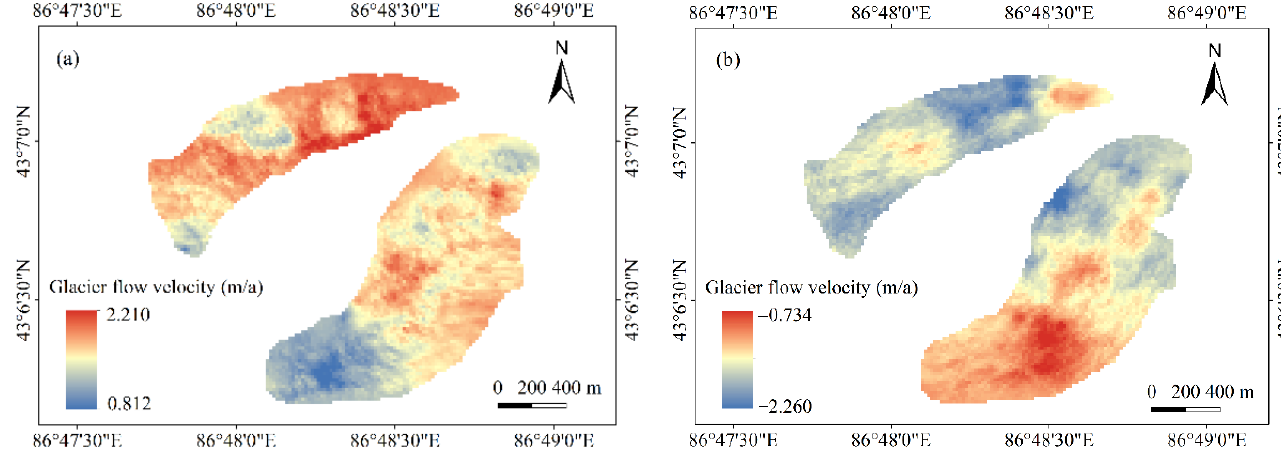
Figure 5. Glacier flow velocity of LOS direction 2016–2017: ( a ) LOS measurements from the ascending tracks; ( b ) LOS measurements from the descending